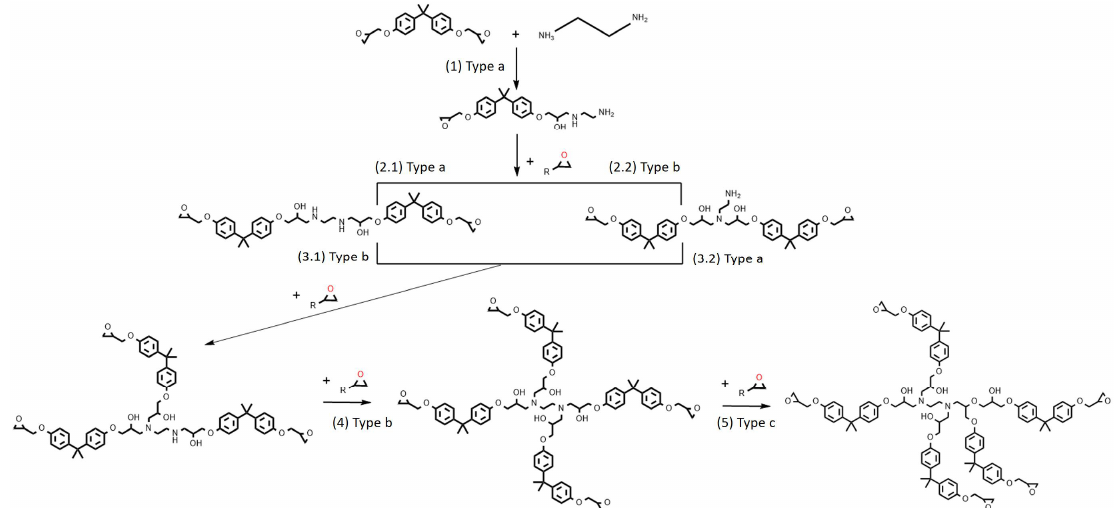
Figure A1. Schematic representation of the crosslinking reaction between (a: epoxide group and primary amine group, b: epoxide group and secondary amine group, and c: epoxide group and the hydroxyl